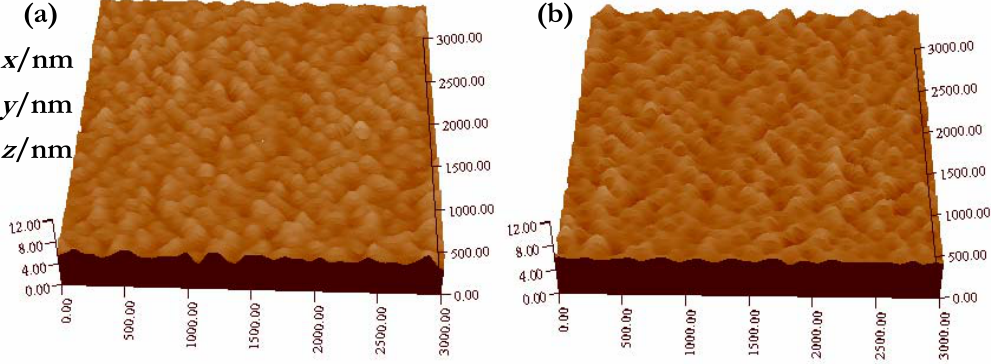
Figure 4. AFM images for (a) pristine and (b) Cd-doped thick